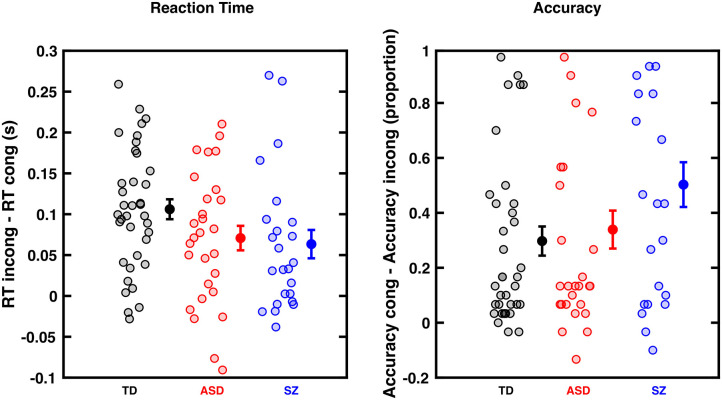
Cross-Modal Congruency Effect (CCE) for RTs (left) and accuracy (right) in typically developing (TD) individuals, as well as Autism Spectrum Disorder (ASD), and Schizophrenic (SZ) patients. (A) CCE is the difference between tactile RTs when preceded by an incongruent or congruent visual cue (measured in seconds). Controls (black) individuals show numerically a larger cross-modal congruency effect than ASD (red) and SZ (blue) individuals, but this difference is not statistically significant. (B) Similar format but subtracting accuracy in incongruent trials from accuracy in congruent trials. Groups did not statistically differ. Dots are individual participants, error bars show the mean and ±1 S.E.M.